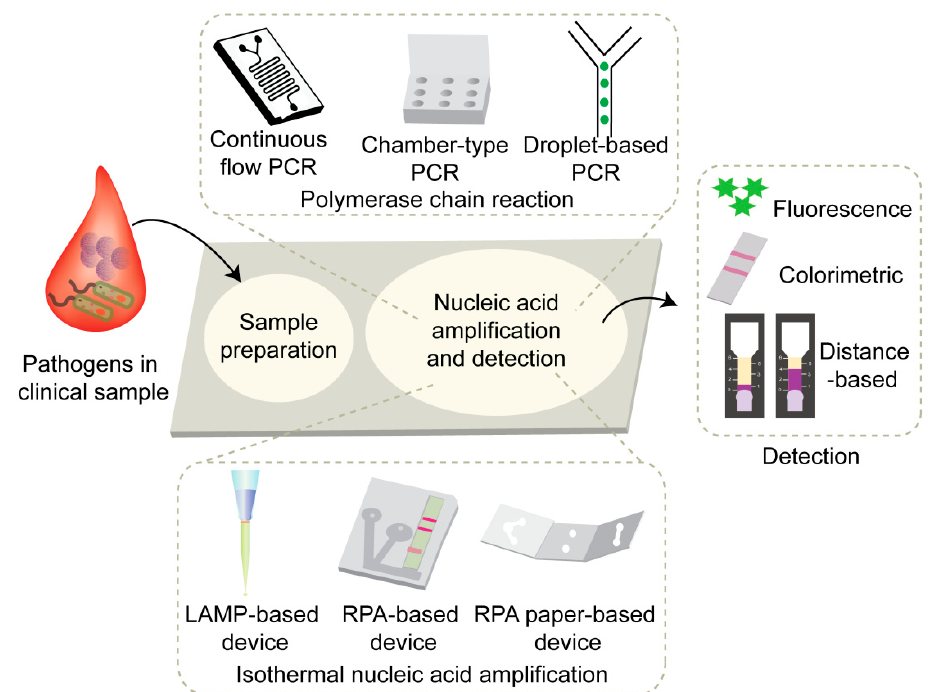
Figure 1. Microfluidic technologies for clinical microbial detection.